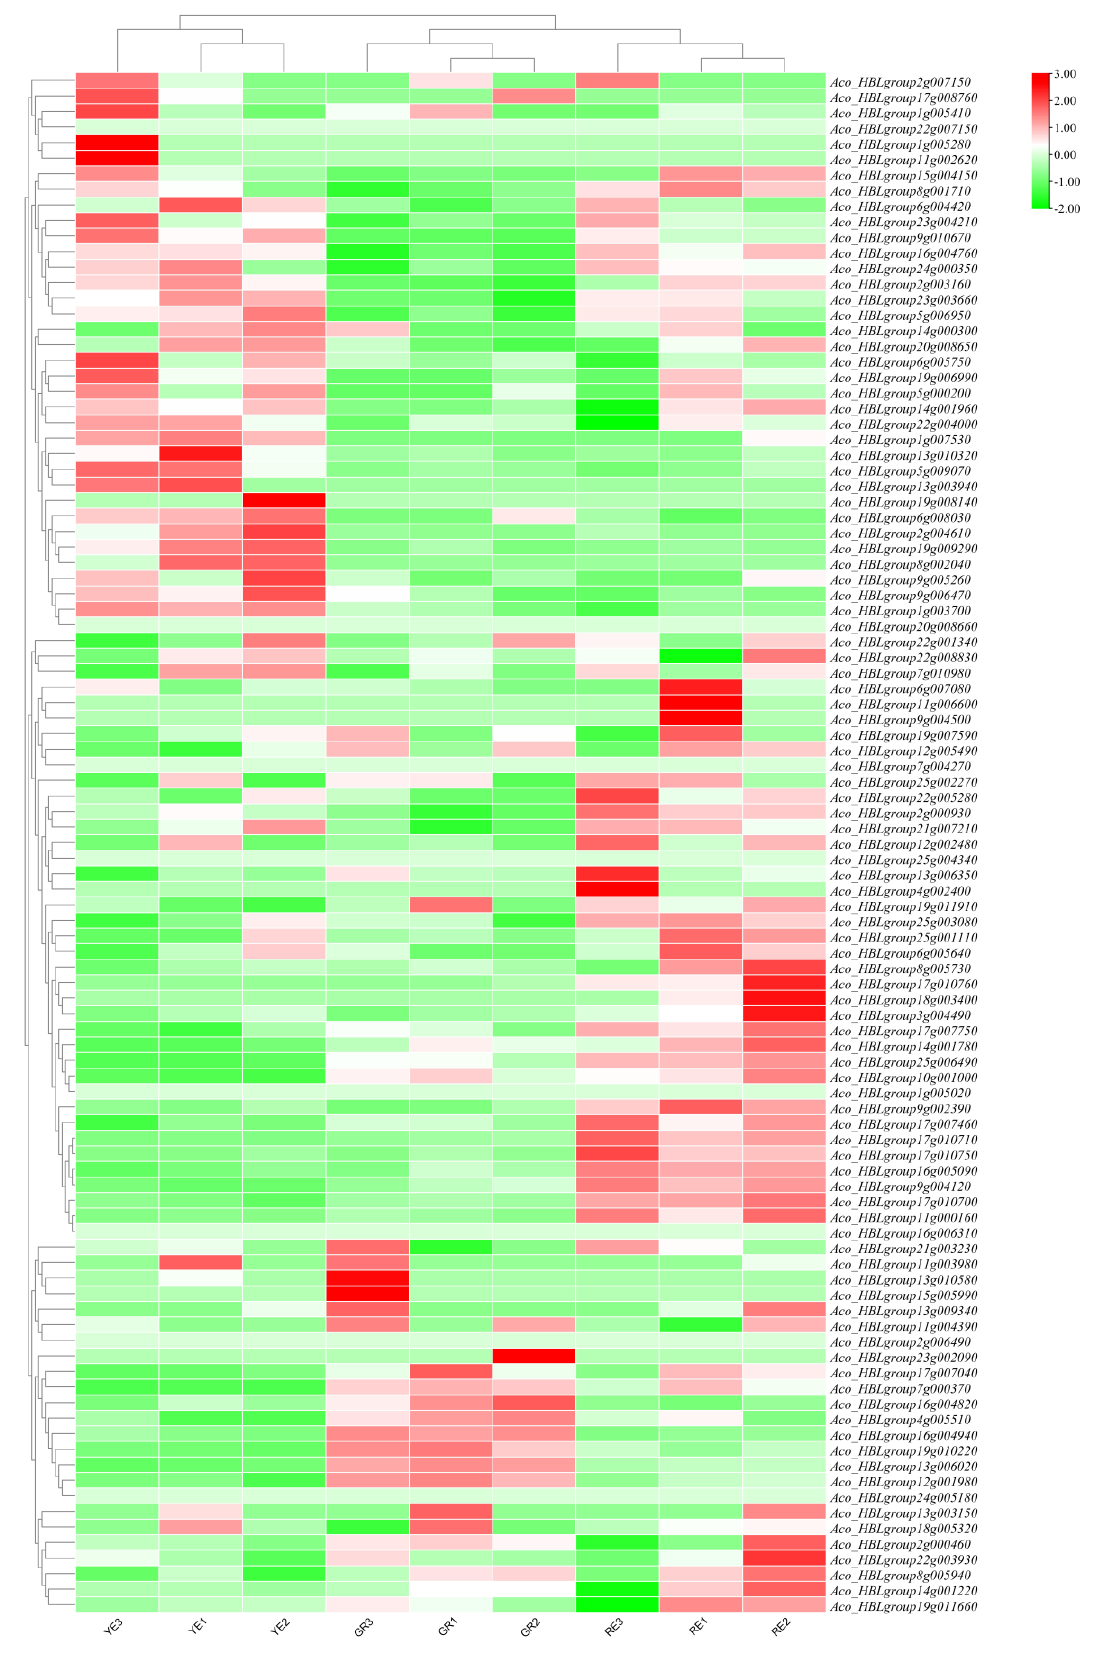
Figure 7. Expression patterns of AbR2R3-MYB genes in green leaves (GR), red leaves (RE), and yellow leaves (YE) of A. comosus var. bracteatus